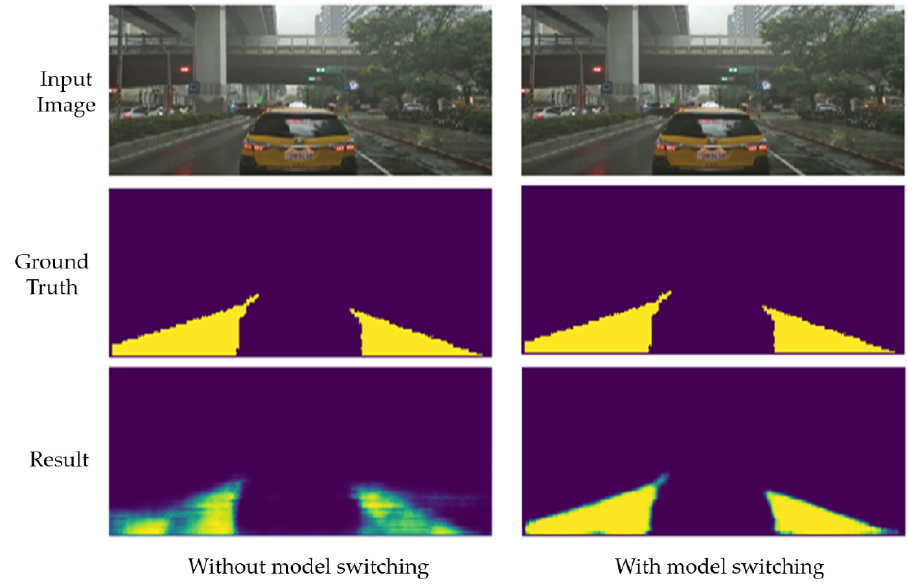
Figure 13. Road semantic segmentation result using model-switching architecture with the LWF-VGG FCNs and LWF-VGG FCN.